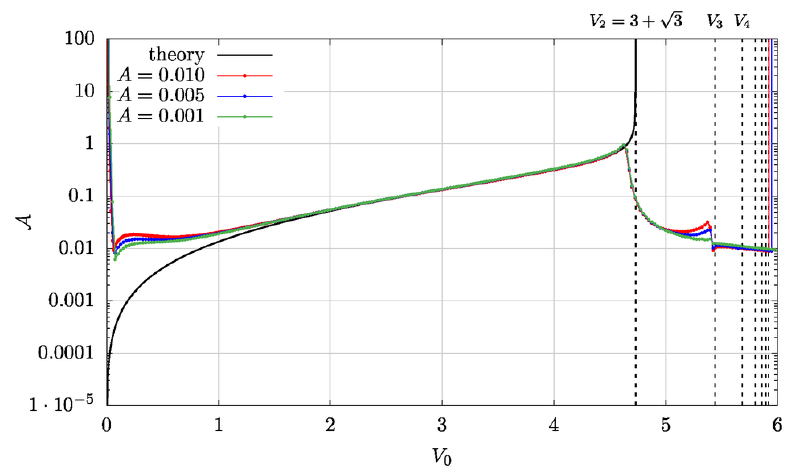
Figure 13 . Radiation measured at x = 200 at t = 1000 (divided by A 2 ) compared with the theoretically predicted values (A.7) (black curve).